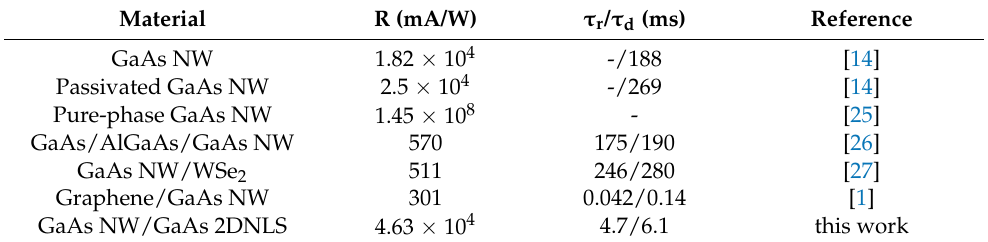
Table 1. Comparison of the performance parameters for low-dimensional GaAs photodetectors.